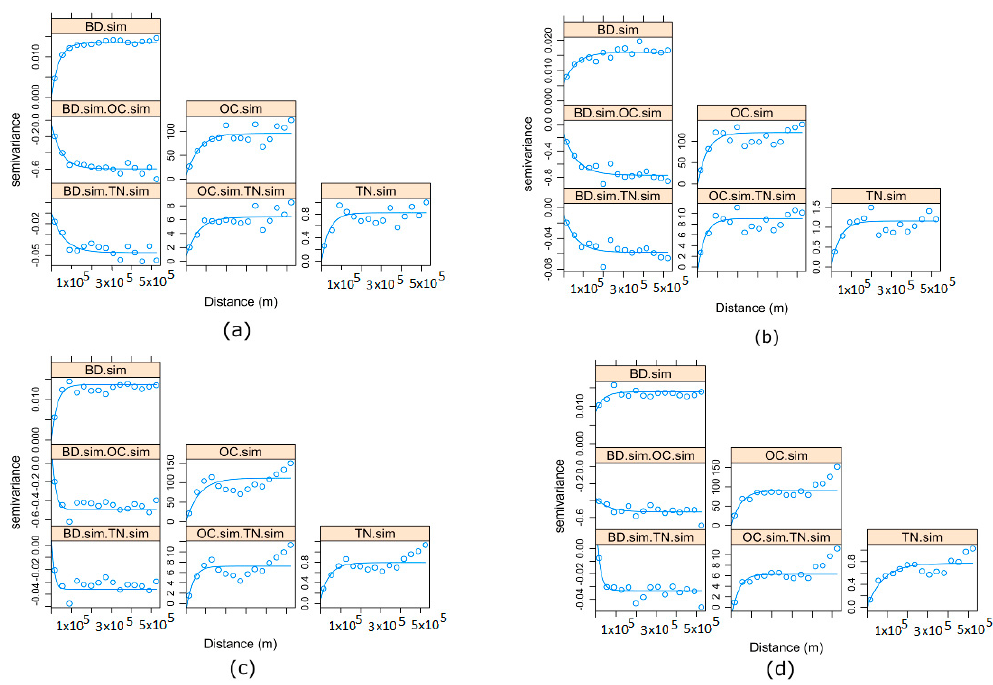
Figure 12. Direct and cross-experimental variograms for randomly selected realizations #36 ( a and b ) and #86 ( c and d ) ( a ) MAF (first column) ( b ) ICA (second column) (BD.sim = bulk density (g / cm 3 ); OC.sim = organic carbon (g / kg); TN.sim = total nitrogen (g / kg)). Semi-variance is expressed in units of each variable.